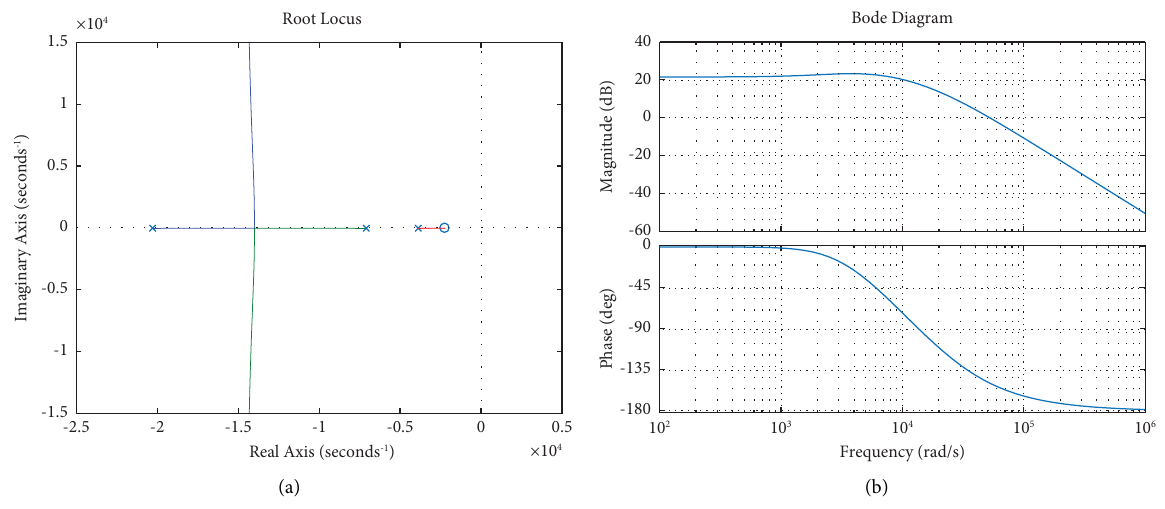
Figure 13: LC flter with series damping: (a) root locus; (b)